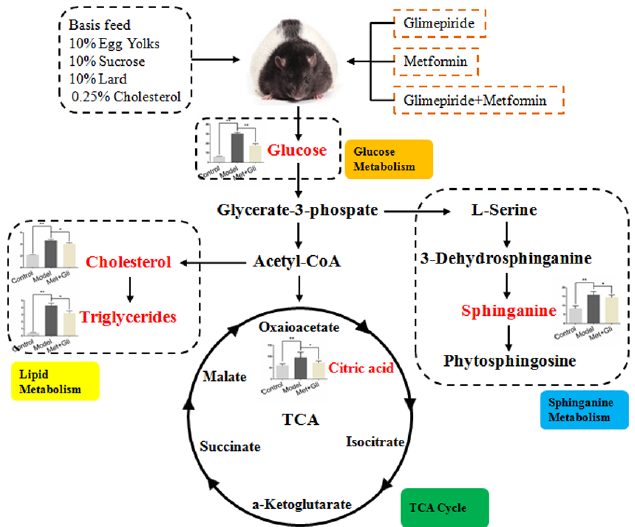
Figure 6. Systemic view of metabolic pathways associated with glimepiride and metformin combination treatment in obese diabetic ZDF rats (fa/fa). The network pathways were identified by the KEGG, HMDB, and METLIN databases. The red color represents the endogenous metabolites that changed when compared with the control group. Orange, yellow, green, and blue colors indicate the names of the related metabolic pathways.